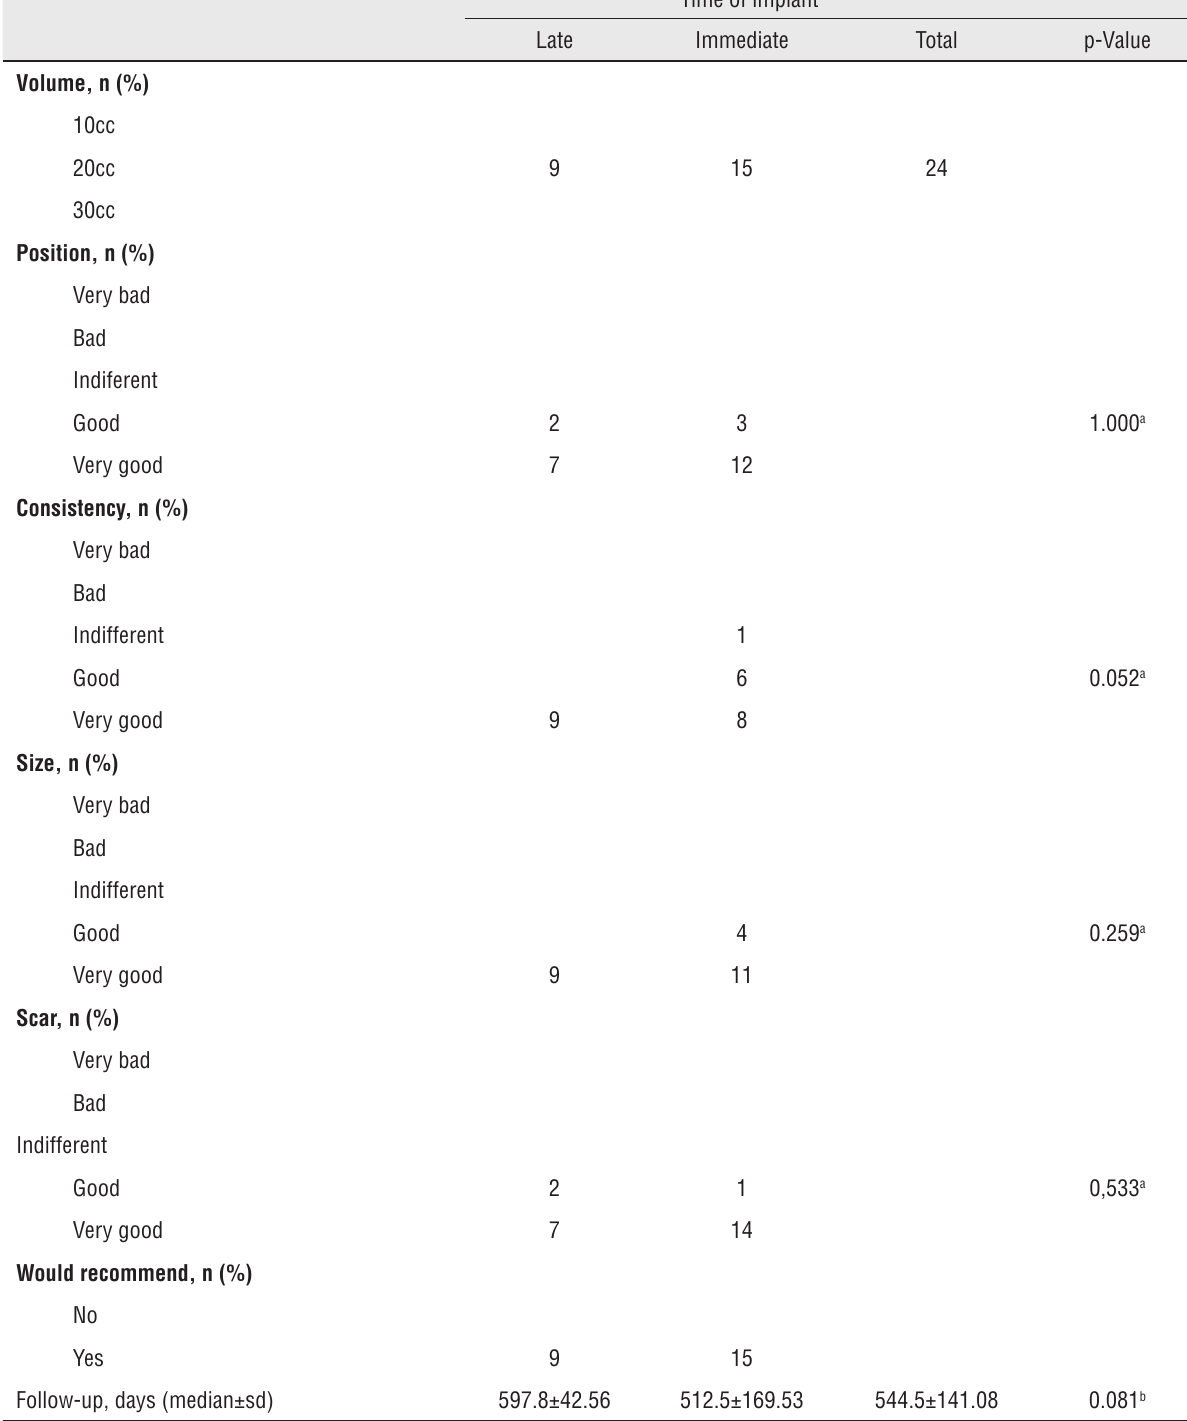
Table 2 - Patient’s satisfaction with the